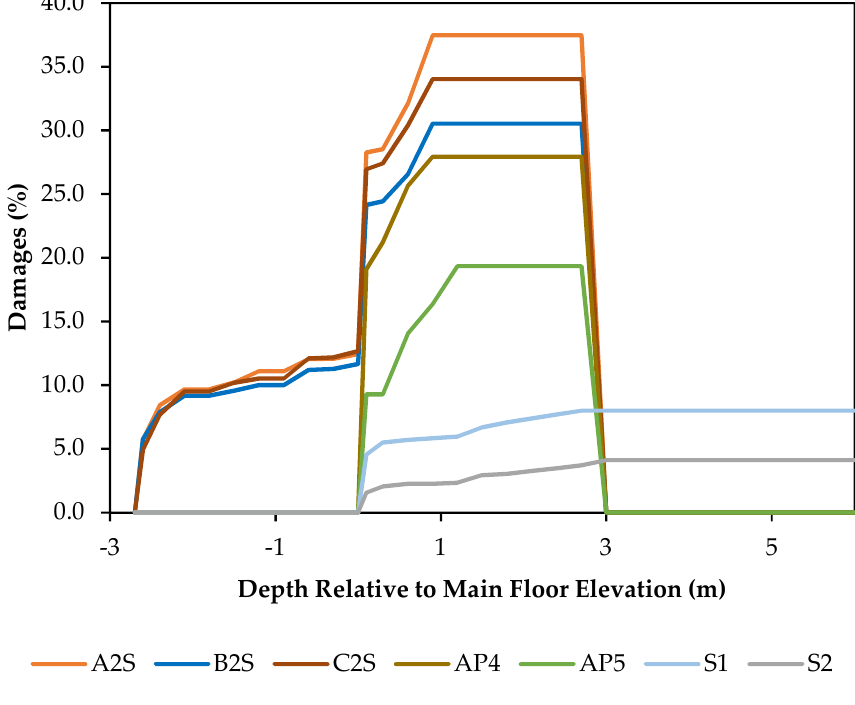
Figure 7. Residential and non-residential depth–damage curves (%).